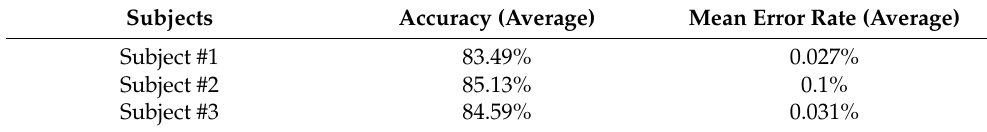
Table 2. Abdomen fat segmentation and classification method results.